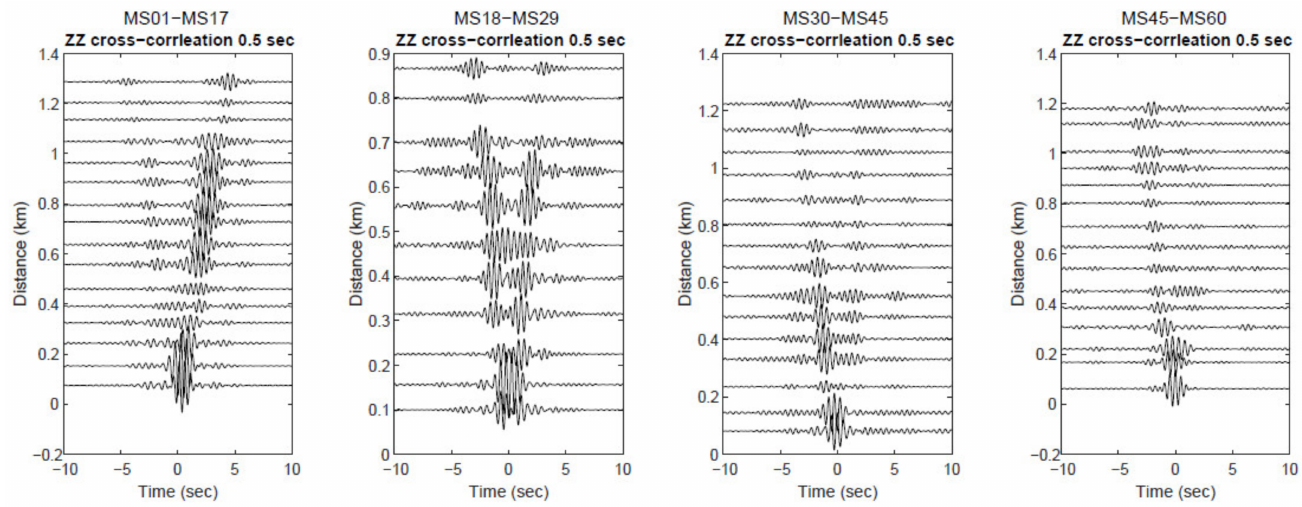
Figure 2. Vertical to vertical component cross correlation from the source station to the receiver stations for each section. The first section is north of the Meishan Fault (MS01 − MS17), and the next section (MS18 − MS29) is inside CCU. The third (MS30 − MS45) and fourth (MS45 − MS60) sections are south of